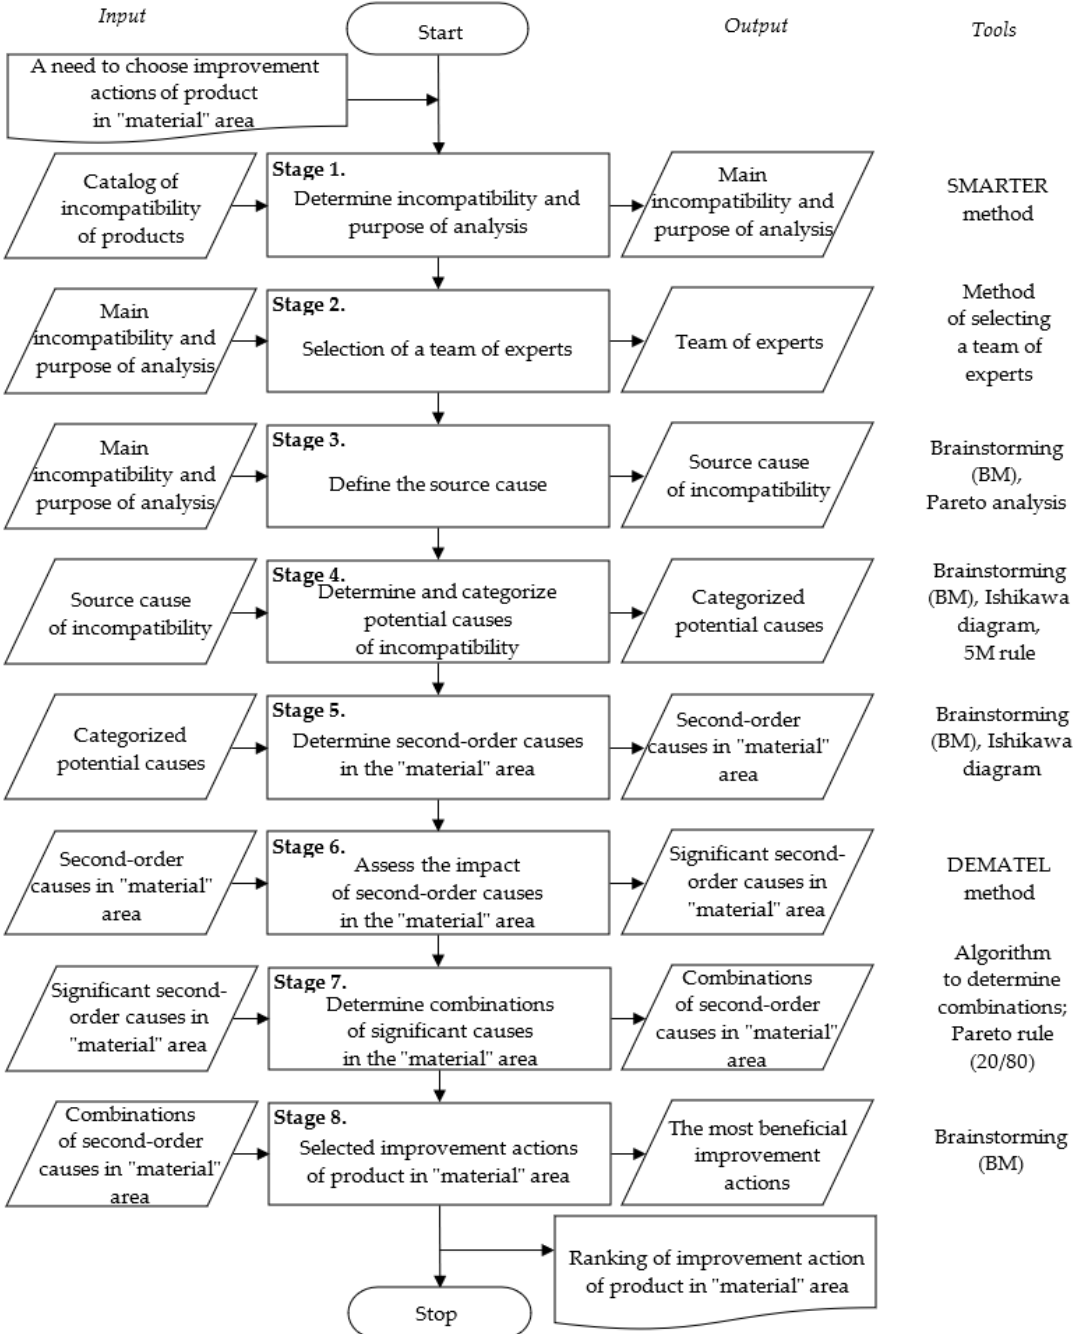
Figure 3. Algorithm of method of determining sequence actions of products improvement. Stage 5. Determine second-order causes in the “ material ” area